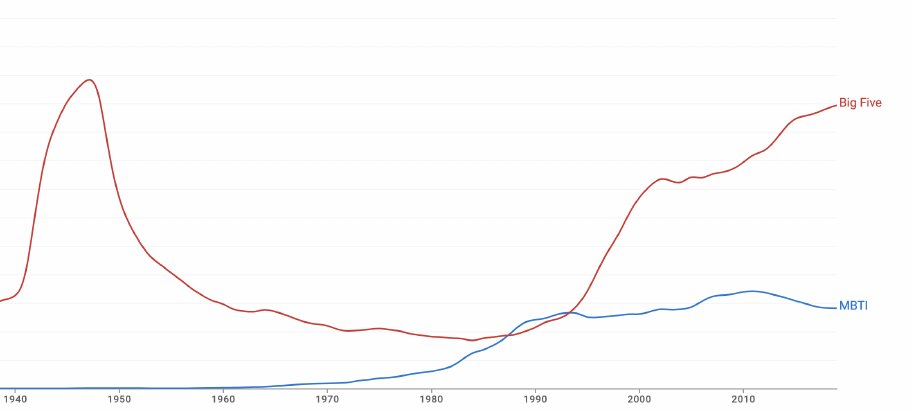
Figure 1. The frequency of personality models in book titles, showcasing interest in scientific circles for different personality models. The graph originates from https://books.google.com/ngrams (accessed on 28 March 2023). We note that the Big Five model is usually referred to as simply the “Big Five” in book